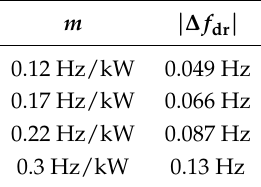
Table 3. Frequency steady-state deviations depending on droop slopes.